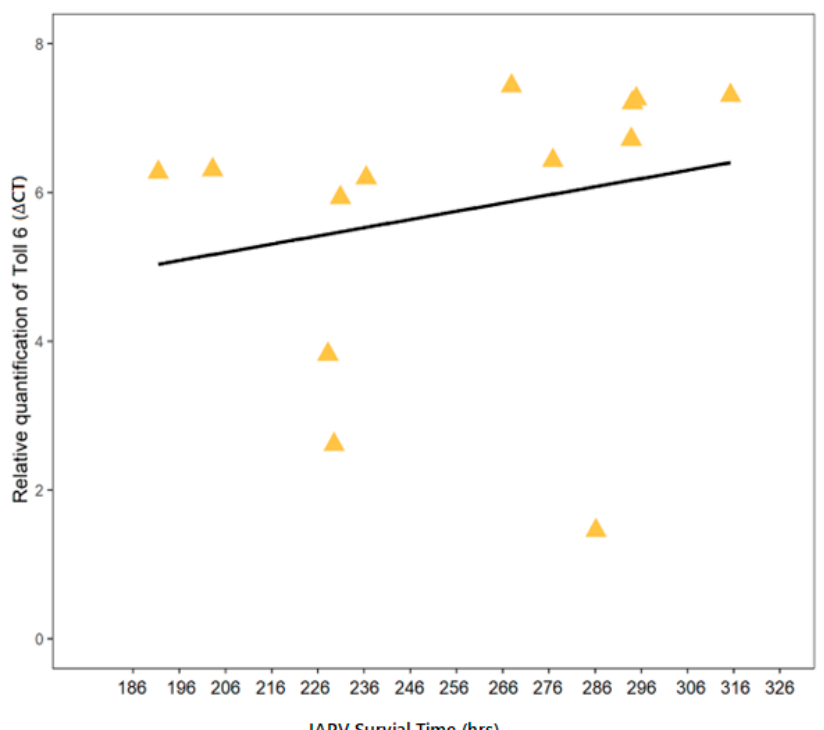
Figure 3. The constitutive expression of the immune gene toll-6 was related to IAPV survival across colonies. Average expression of toll-6 (measured in pretreatment samples as ∆ CT relative to two reference genes) was positively correlated (Rs = 0.56, n = 13, p = 0.0499) to average IAPV survival across colonies. Yellow triangles indicate individual data points and the black line describes the linear trend.